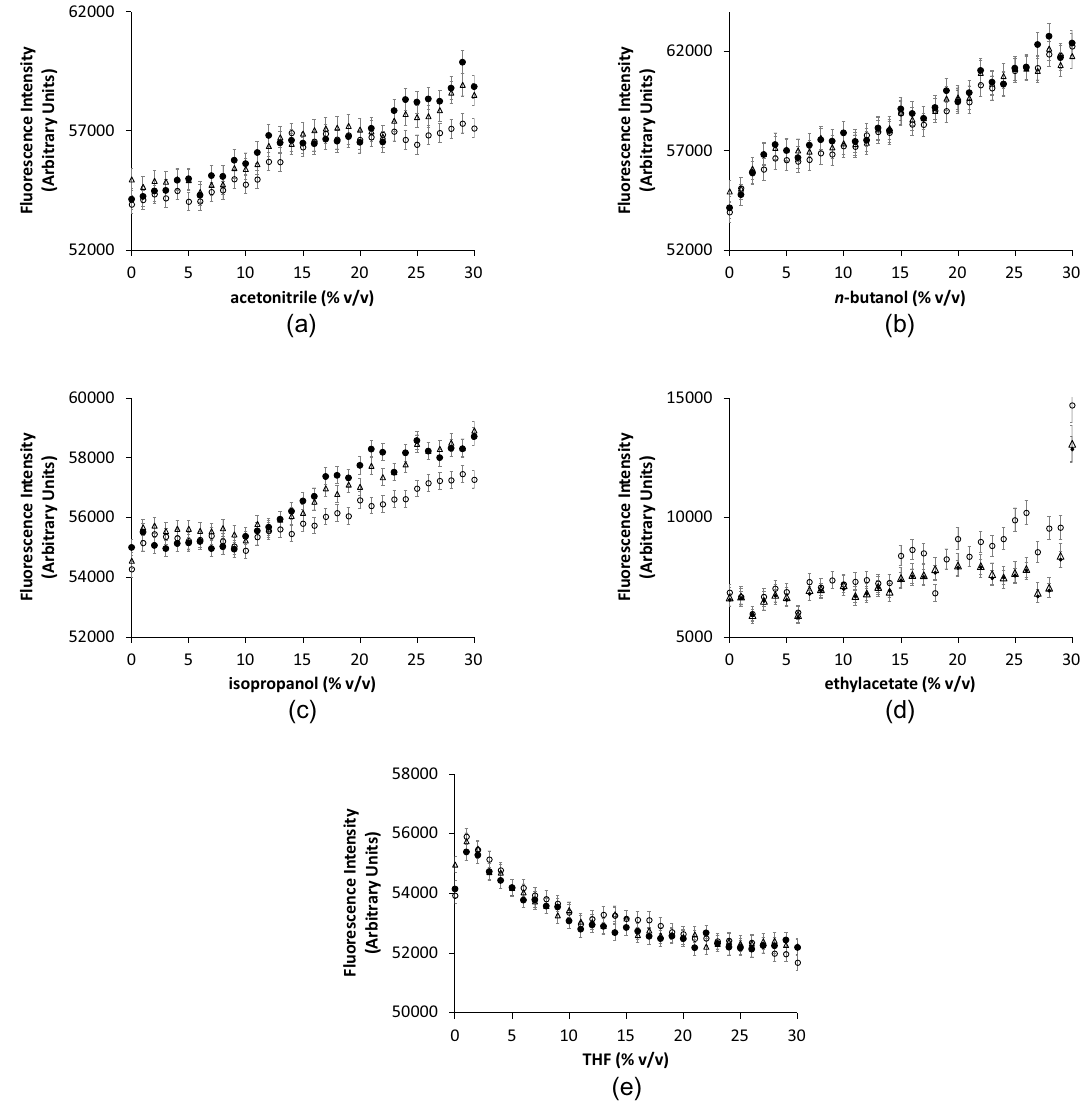
Figure 9. Fluorescence intensity measurements of holo-TK after incubation with increasing concentrations of organic solvents. Fluorescence intensity was measured at 340 nm with excitation at 280 nm. Holo-TK at 0.1 mg mL −1 in 5 mM MgCl 2 , 0.5 mM TPP, 25 mM Tris–HCl, pH 7.0, was incubated with ( a ) acetonitrile ( b ) n-butanol ( c ) ethyl acetate ( d ) Isopropanol ( e ) THF for (open circle) 1 h, (open triangle) 2 h, (filled circle) 3 h at 25 °C prior to measurements. Error bars represent one standard deviation about the mean (n =